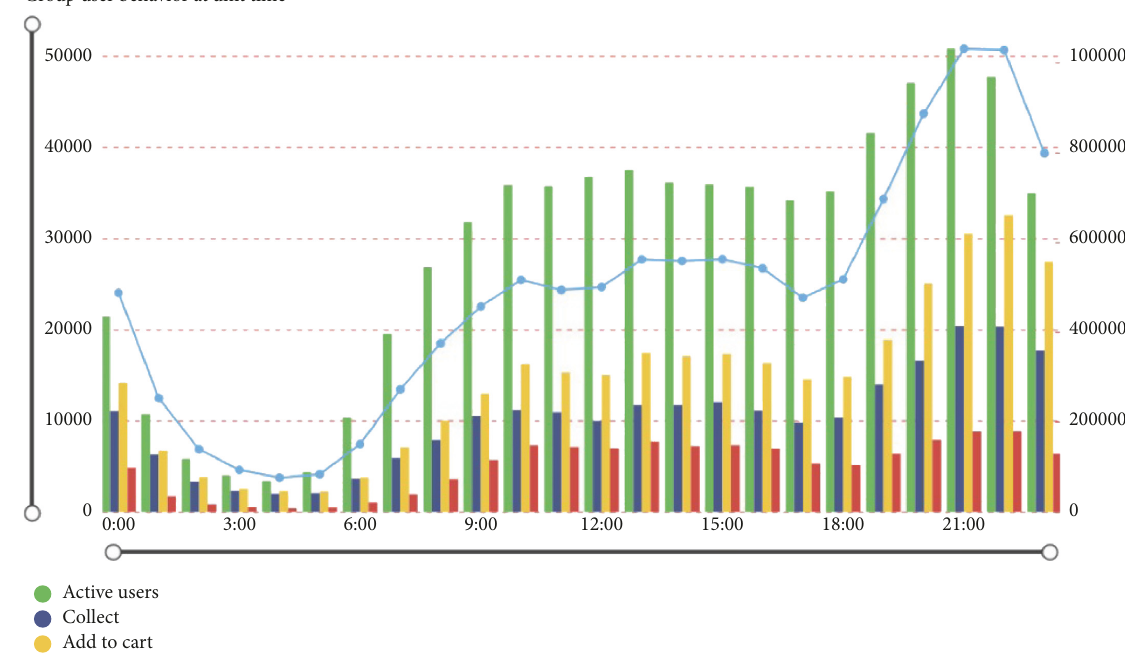
Figure 8: Change trend of group user